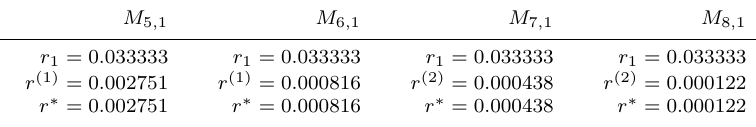
Table 2. Numerical results for example 2